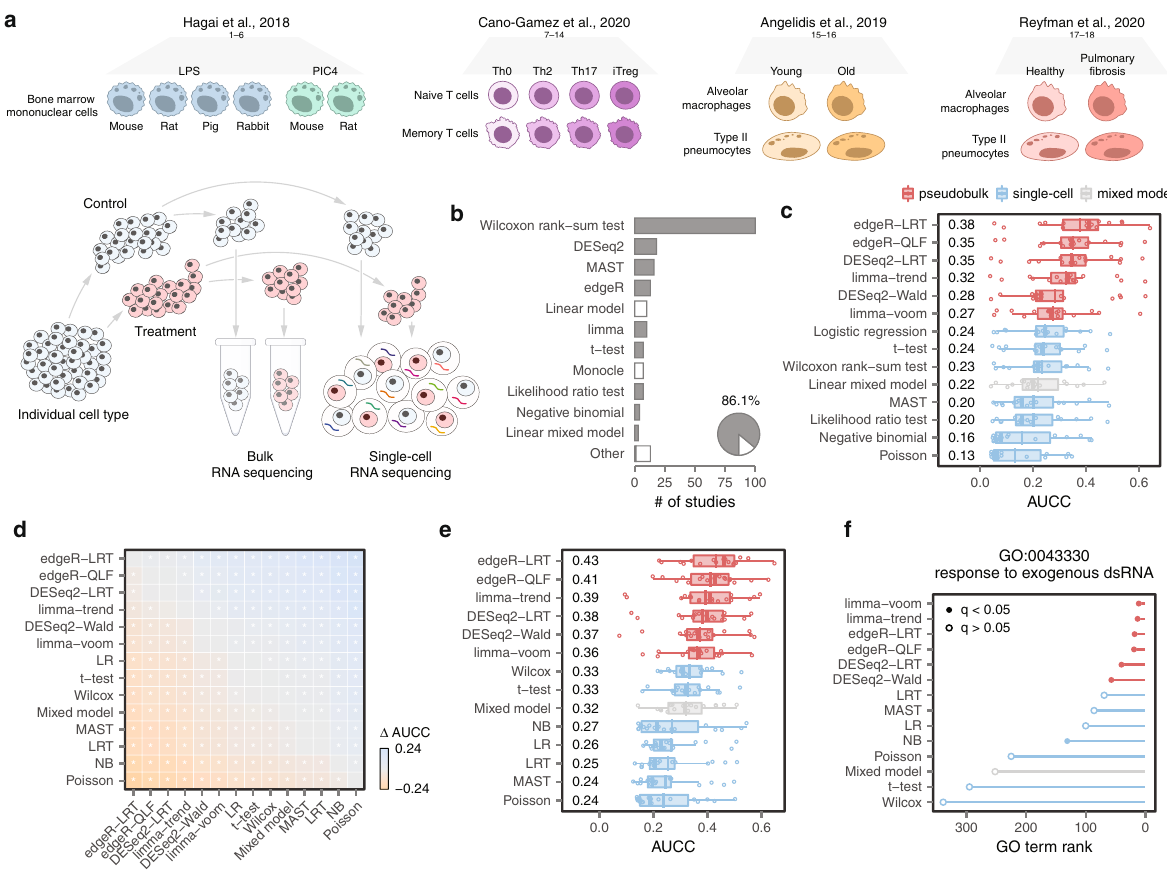
Fig. 1 A systematic benchmark of differential expression in single-cell transcriptomics. a Schematic overview of the eighteen ground-truth datasets analyzed in this study. b Statistical methods for DE analysis employed in 500 recent scRNA-seq papers. Grey bars represent DE analysis methods included in this study. “ Other ” includes methods used in two or fewer studies. Inset pie chart shows the total proportion of recent scRNA-seq papers that employed DE analysis methods included in this study. Source data are provided as a Source Data fi le. c Area under the concordance curve (AUCC) for fourteen DE methods in the eighteen ground-truth datasets shown in a . d Mean difference in the AUCC ( Δ AUCC) between the fourteen DE methods shown in c . Asterisks indicate comparisons with a two-tailed t-test p-value less than 0.05. e AUCC of GO term enrichment, as evaluated using gene set enrichment analysis 46 , in the eighteen ground-truth datasets shown in a . f Rank and statistical signi fi cance of the GO term GO:0043330 ( “ response to exogenous dsRNA ” ) in GSEA analyses of mouse bone marrow mononuclear cells stimulated with poly-I:C, a type of synthetic dsRNA, for four h, using the output of fourteen DE methods. Source data are provided as a Source Data fi